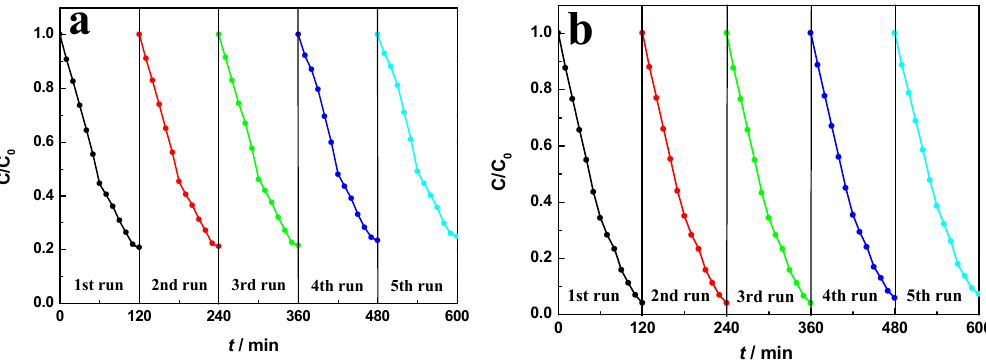
Figure 10. Recycle curves of FT3 for the degradation of the ( a ) 5 × 10 − 5 mol·L − 1 RhB solution under visible light irradiation and the ( b ) 2 × 10 − 5 mol·L − 1 RhB solution under solar light irradiation.